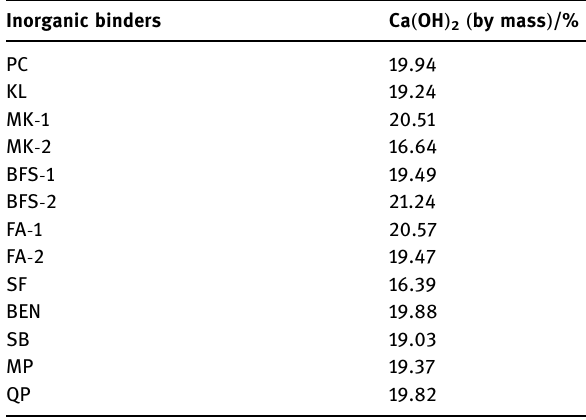
Table 3: Ca ( OH ) 2 content of inorganic binders after curing for 7 days Inorganic